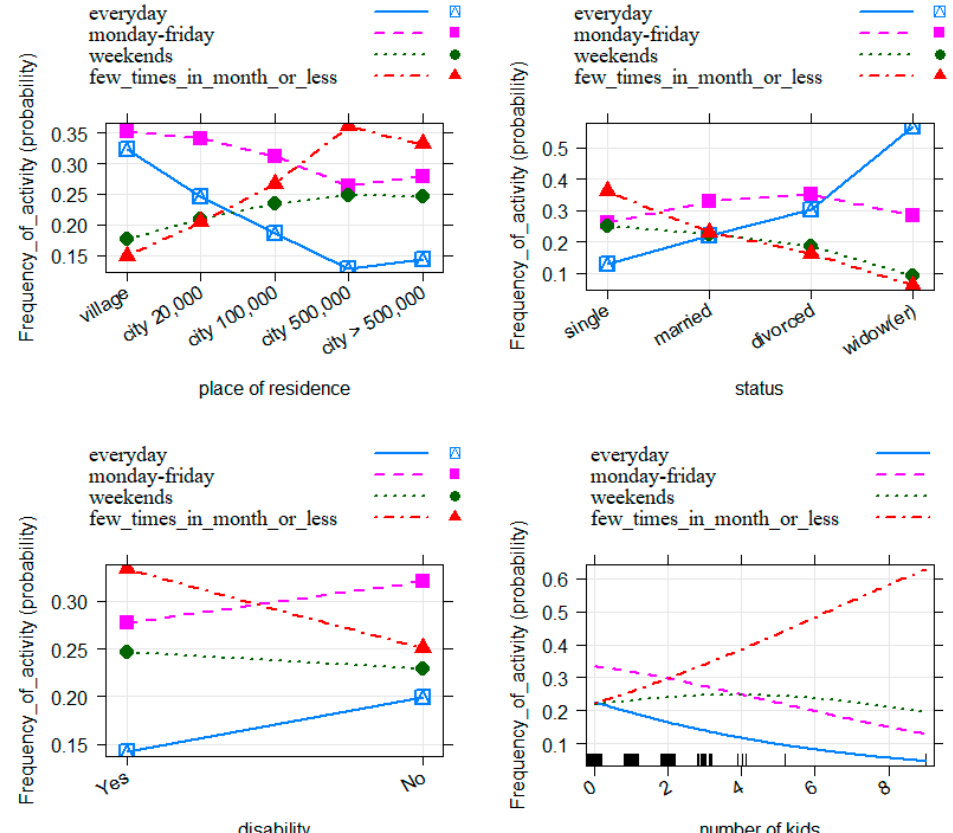
Figure 2. Frequency of urban green recreation response for significant demographic variables (source: own computations).